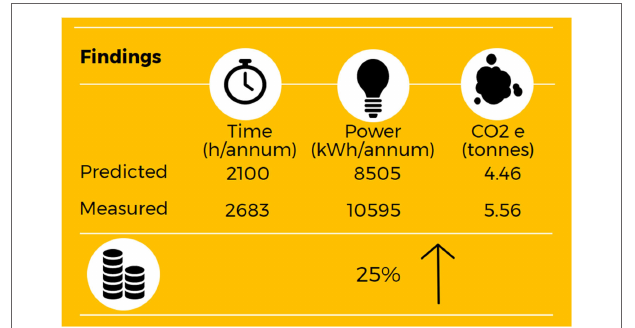
FigUre 11 | Urban 2 and Urban 3 CO 2 e and electricity consumption analysis.